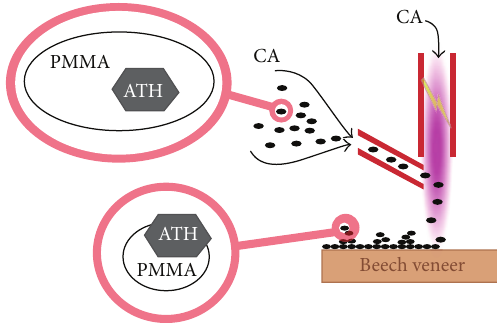
Figure 8: Visualisation of the plasma-induced modification of PMMA/ATH by atmospheric pressure plasma powder